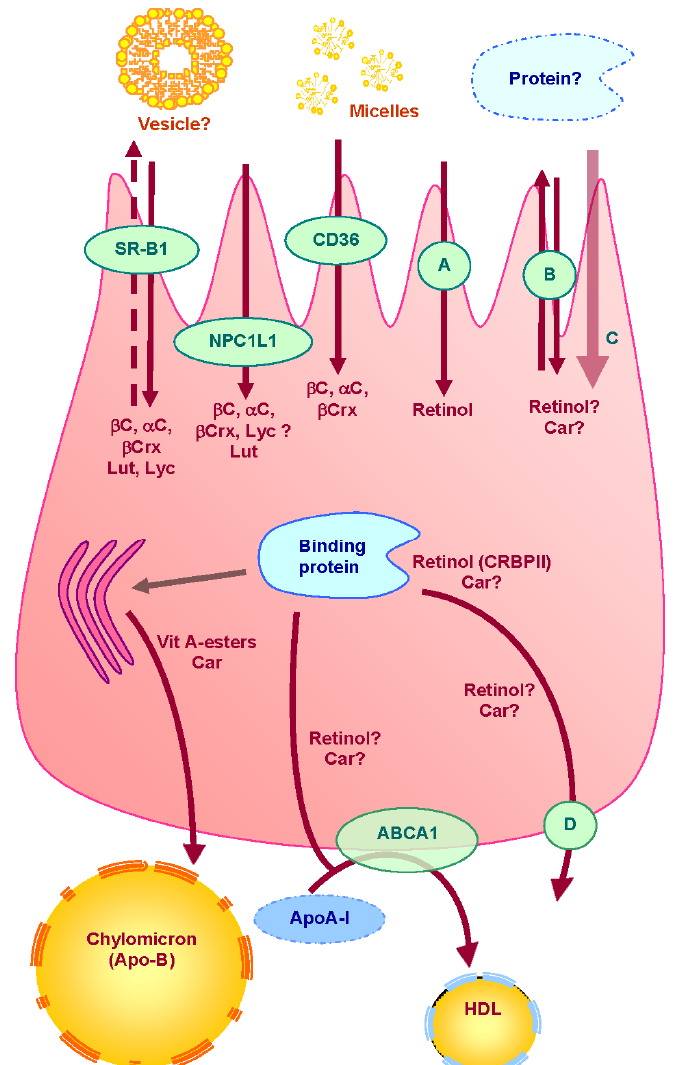
Figure 1. Proteins involved in uptake, transport and secretion pathways of vitamin A and carotenoids across the